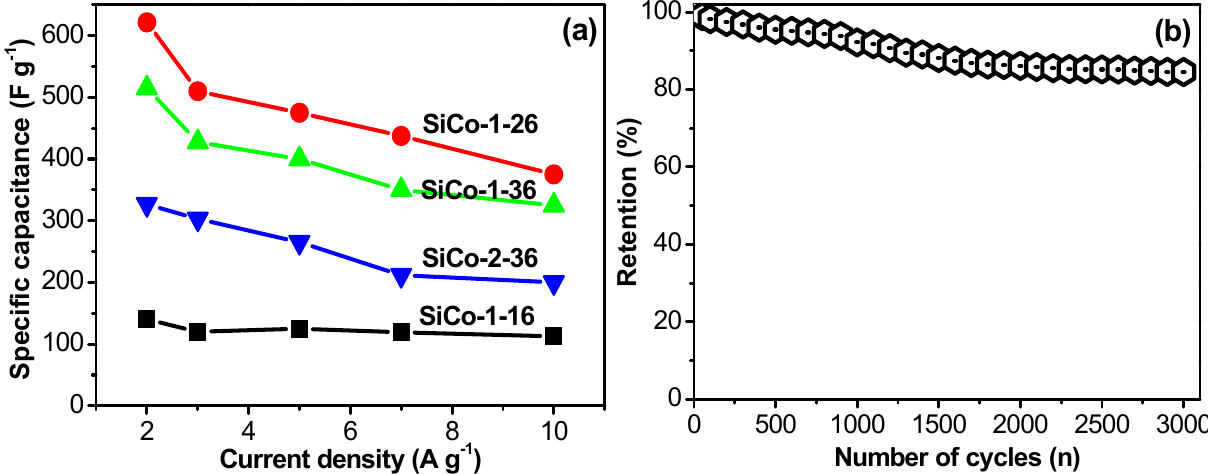
Figure 10. ( a ) Calculated specific capacitance of the SiCo-1-16, SiCo-1-26, SiCo-1-36 and Si/Co-2-36 LDH electrodes at different current densities; and ( b ) cyclic stability of SiCo-1-26 LDH electrodes over 3000 cycles.